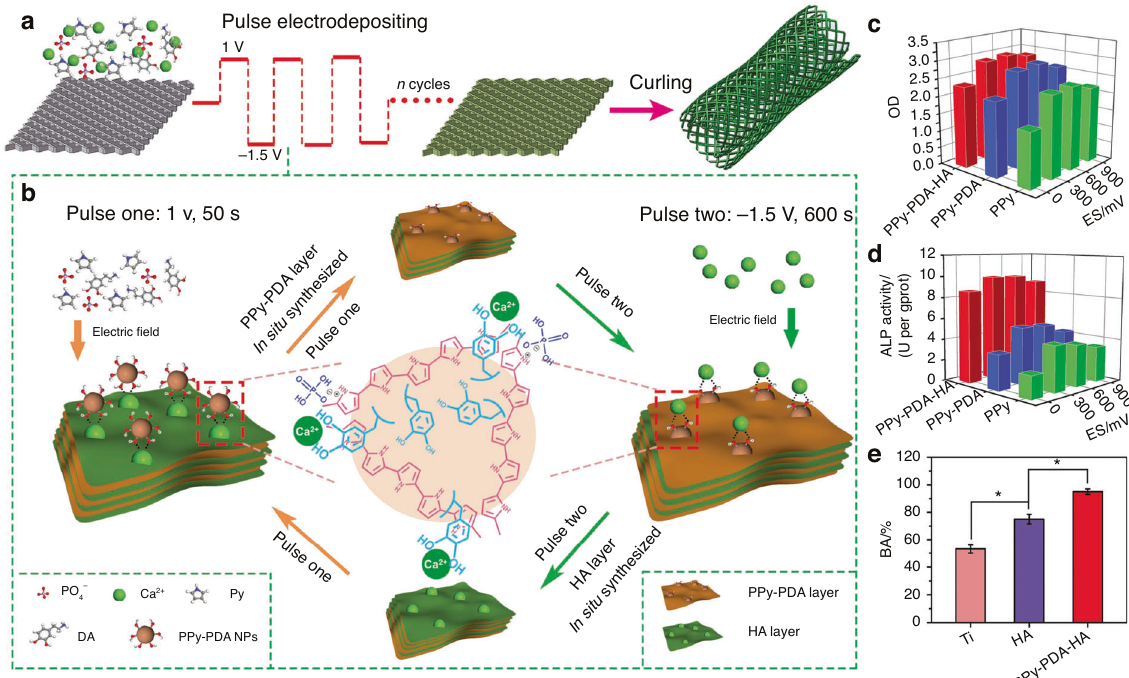
Fig. 7 A mussel-inspired persistent ROS-scavenging, electroactive, and osteoinductive scaffold based on electrochemical-driven in situ nanoassembly. a Scheme of the fabrication of PPy-PDA-HA-coated scaffolds by curling after coating a PPy-PDA-HA fi lm on a titanium mesh. b Fabrication of the PPy-PDA-HA fi lm by layer-by-layer pulse electrodeposition (LBL-PED) method. c proliferation, and d differentiation of BMSCs on the PPy, PPy-PDA, and PPy-PDA-HA fi lms under different electrical stimulation potentials. e Comparison of bone area (BA) from histomorphometry. Reproduced with permission (* P < 0.05). 77 Copyright 2019,